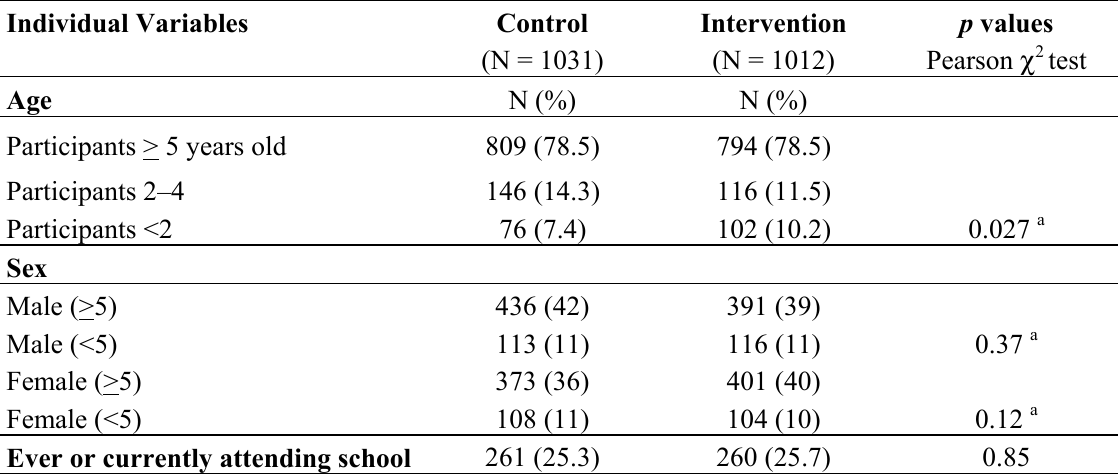
Table 1. Age (as of May 2008), sex and education status of participants in control (no BSF) and intervention (BSF) households during a randomized controlled trial of the plastic BSF in rural Tamale, Ghana 2008.